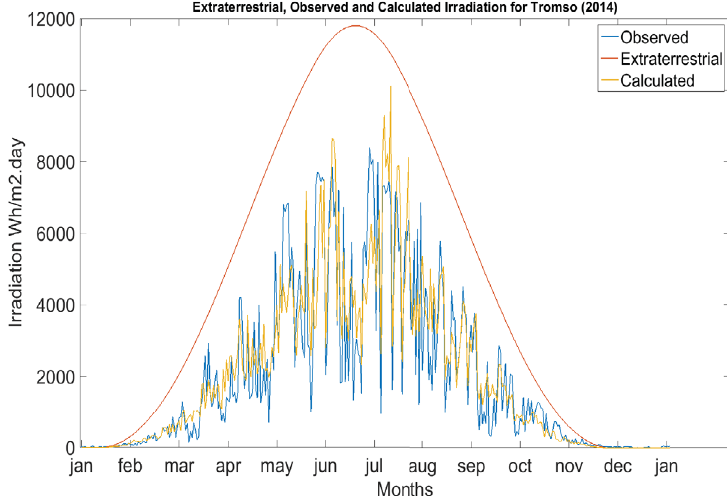
Fig. 1. Observed, calculated and extraterrestrial radiation.